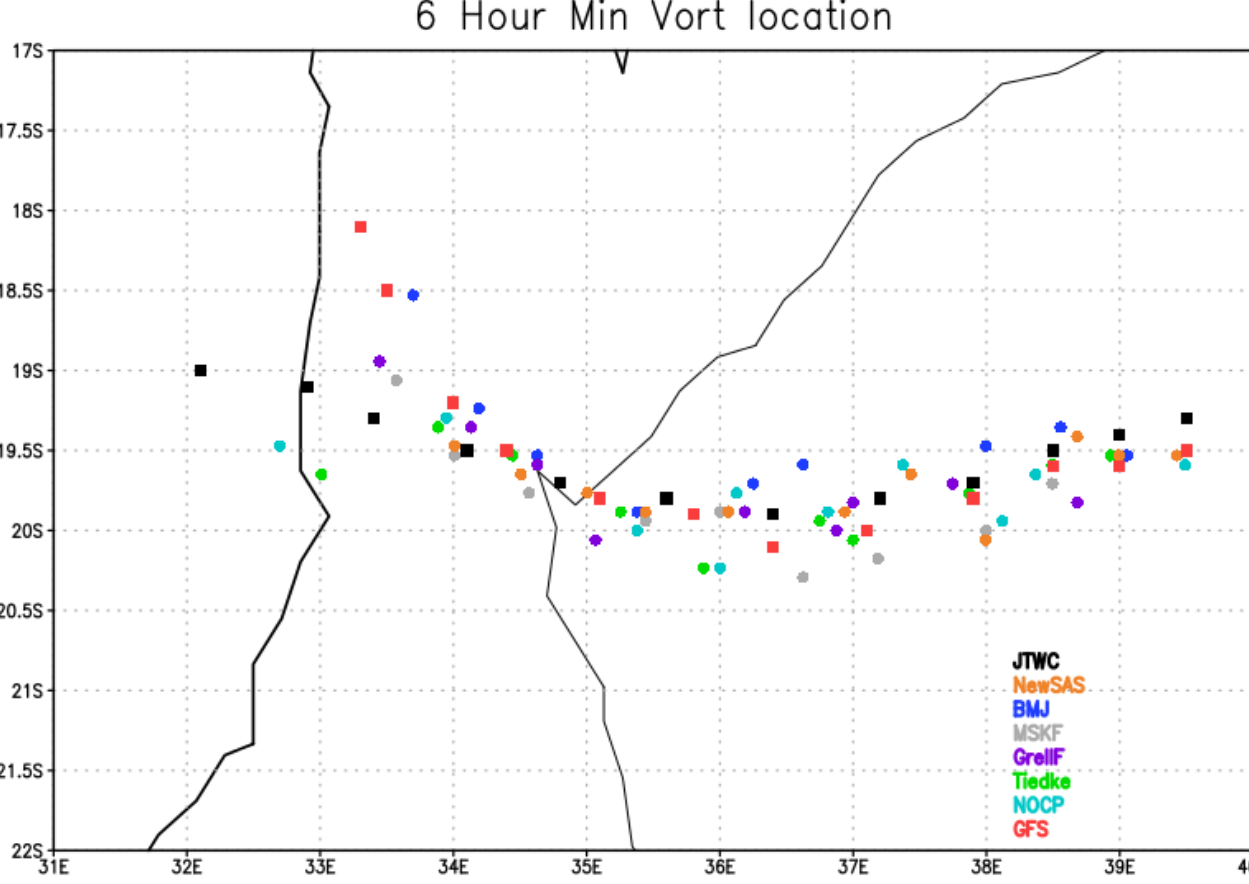
Figure 9. The simulated location of tropical cyclone Idai using 6 h data that match the JTWC time interval for the six experiment, GFS as well as JTWC reported